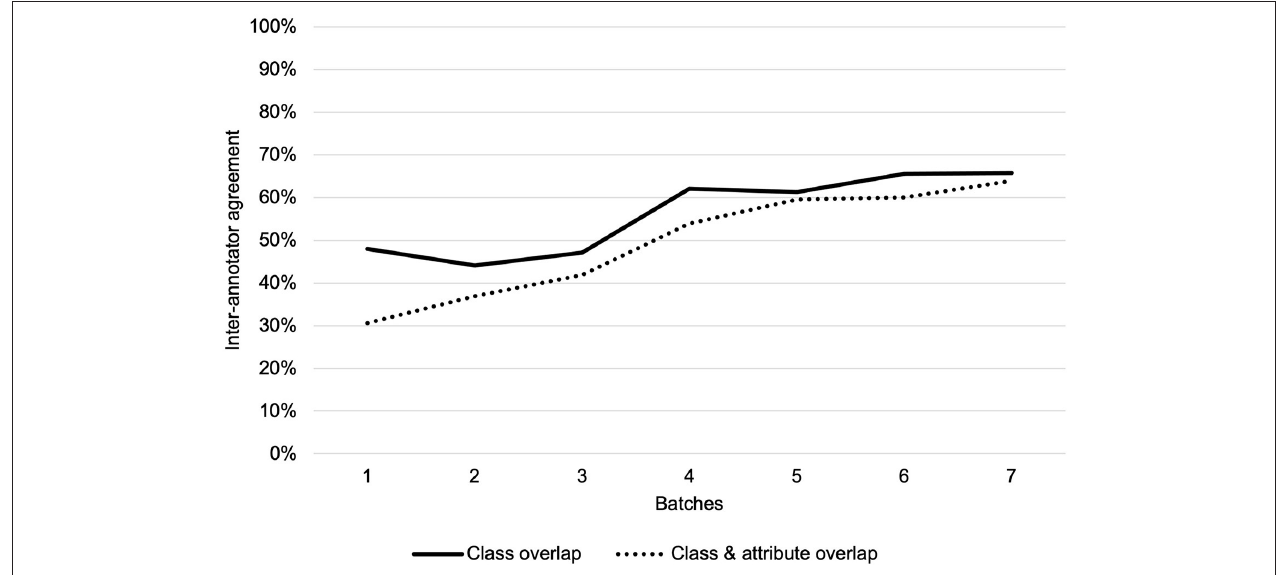
FIGURE 2 | Inter-annotator agreement over seven annotation batches for class overlap and class and attribute